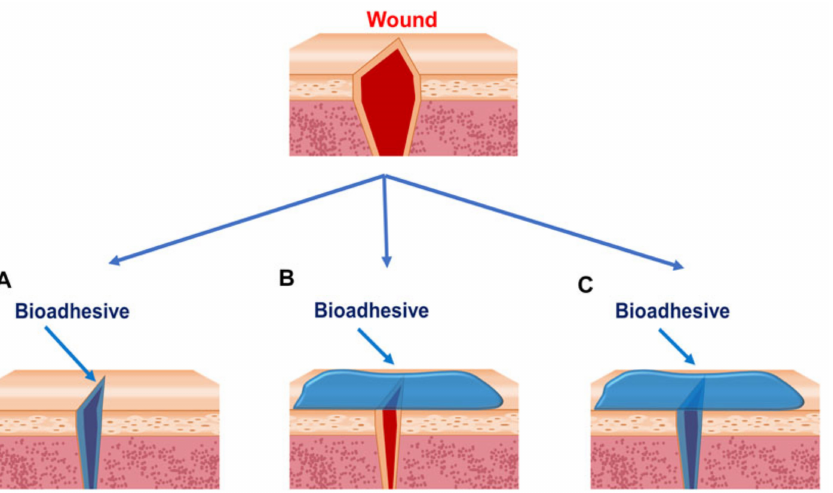
Figure 2. Strategies for bioadhesives used to close wounds. ( A ) Bioadhesives are applied between wound edges. ( B ) Bioadhesives are applied outside of the wounds. ( C ) Bioadhesives are applied between and outside the wounds. Reprinted with permission from Ref.